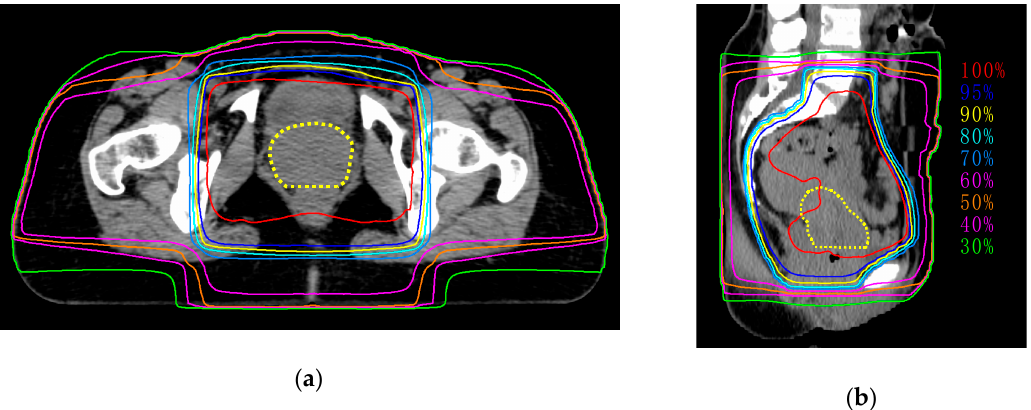
Figure 2. Representative images of dose distribution of external beam radiotherapy. Dashed line indicates tumor (yellow). ( a ) Axial plane; ( b ) sagittal plane.